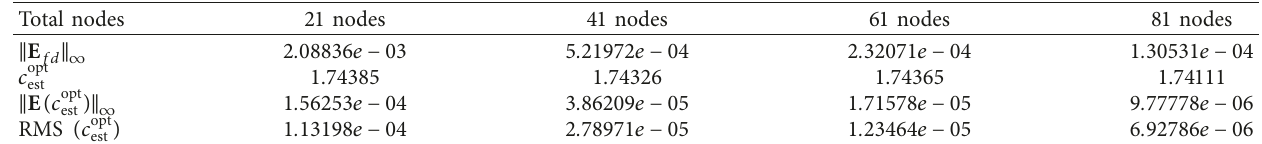
Table 4: Comparing c opt est and its related errors for problem (23).